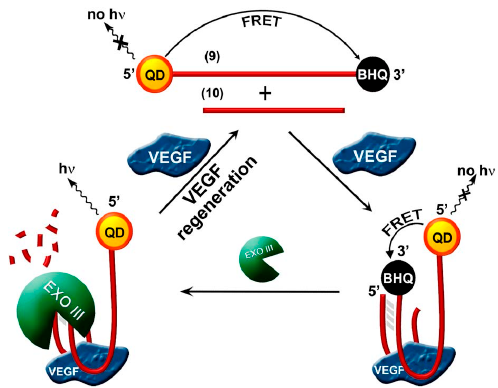
Figure 4. Fluorescence sensing of VEGF is amplified with two aptamer subunits 9 and 10, and Exo III- catalyzed VEGF regeneration